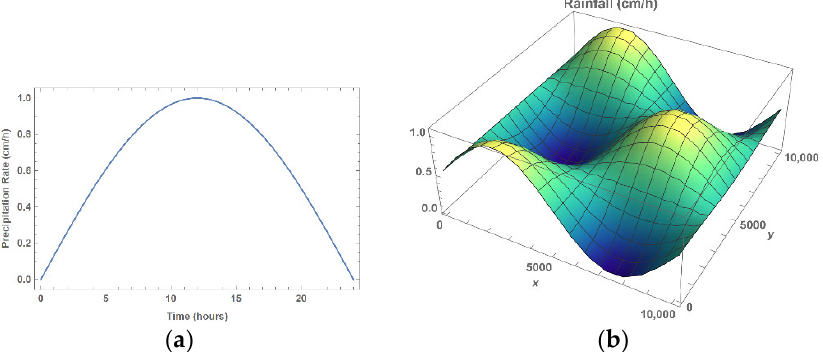
Figure 2. ( a ) Temporal variation of precipitation intensities over a one-day simulation (value indicated in figure applied over the entire spatial domain), ( b ) Spatial variation of precipitation intensities (distribution applied for entire length of simulation for spatially varying test case and scaled by factor of zero to one for the spatial and temporally varying test case).